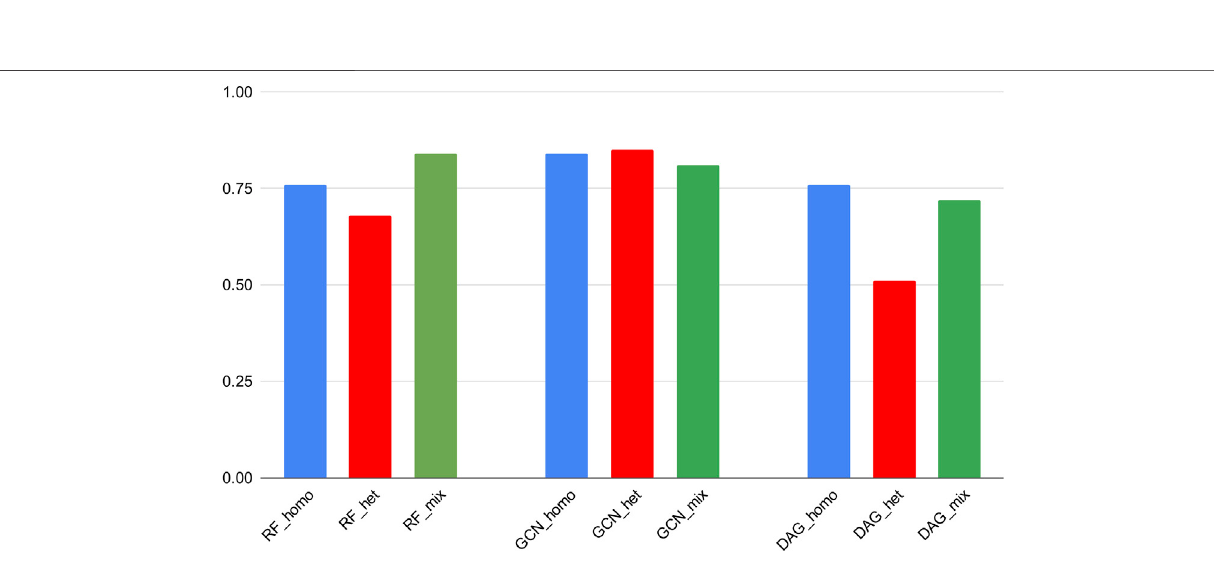
Frontiers in Genetics |